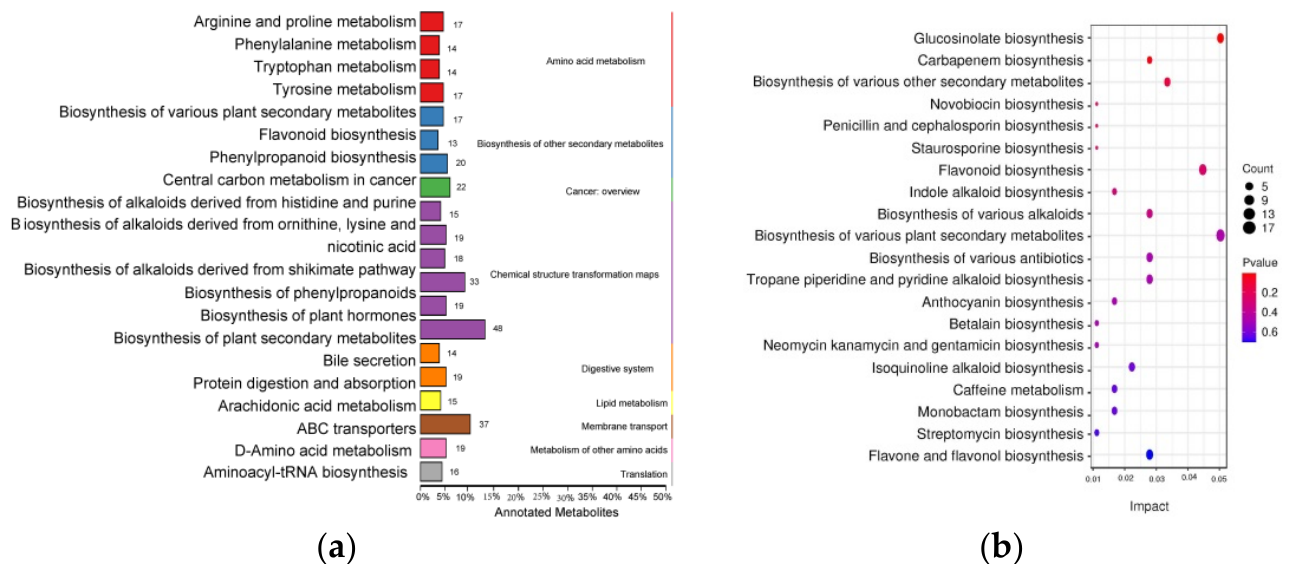
Figure 2. KEGG enrichment pathway of different metabolites of the bark (P) and leaves (Y) of H. chrysantha . ( a ) KEGG differential metabolite classification diagram. The ordinate is the name of the KEGG metabolic pathway, and the abscissa is the number of metabolites annotated by this pathway and its proportion compared with the total number of metabolites annotated. ( b ) Scatter diagram of the enrichment of differential metabolites in KEGG pathways.